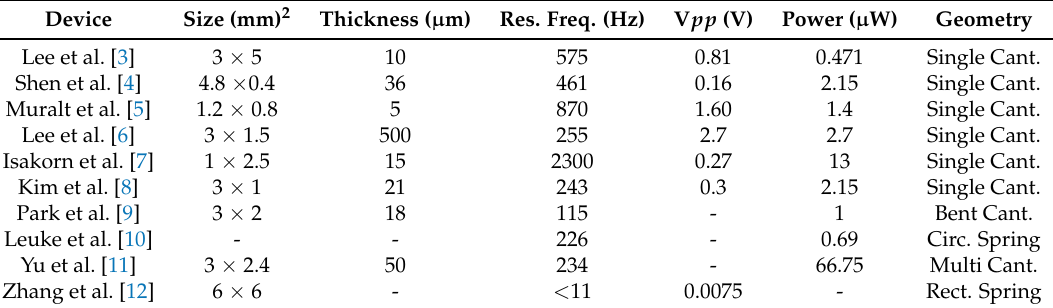
Table 1. List of single cantilevers fabricated in the literature with their